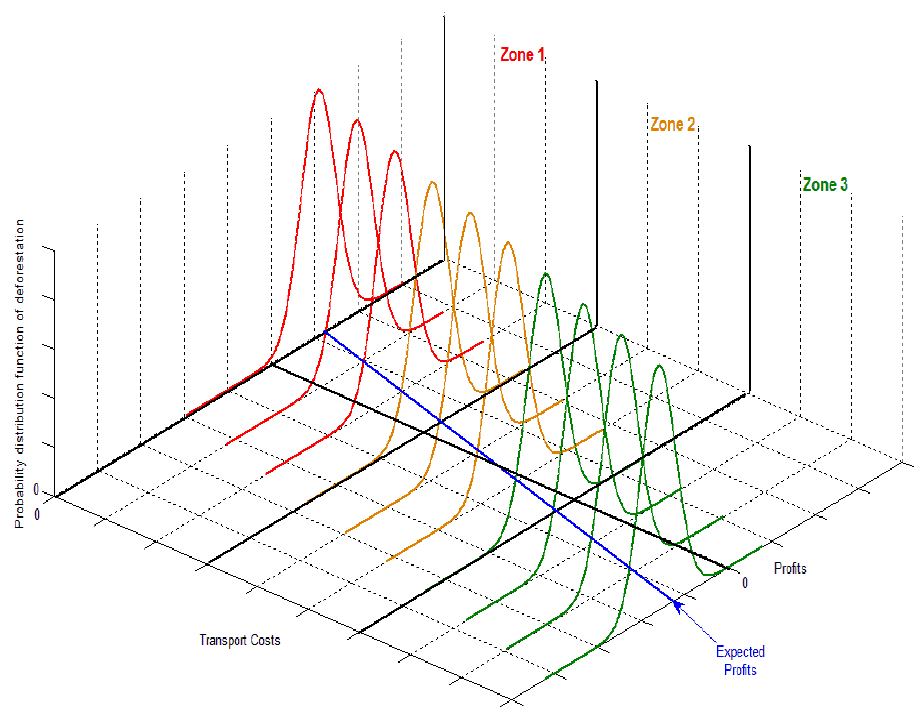
Figure 1. Expected Profits Across Landscape with Implications for PA Impact & Siting